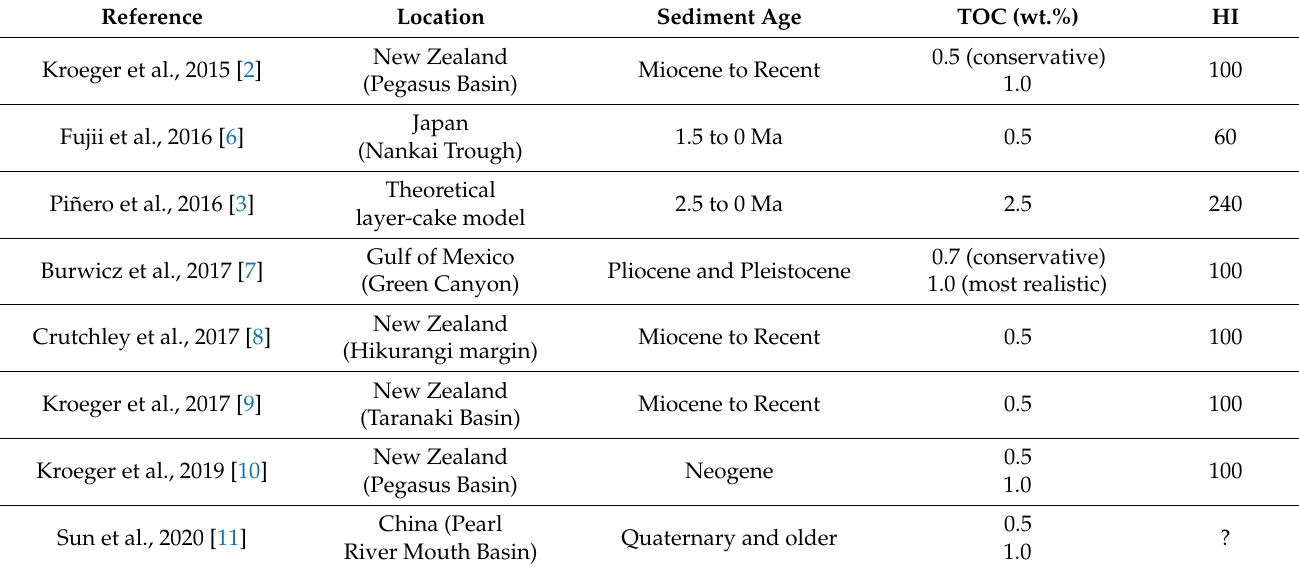
Table 3. Sediment organic contents used in the modelling studies